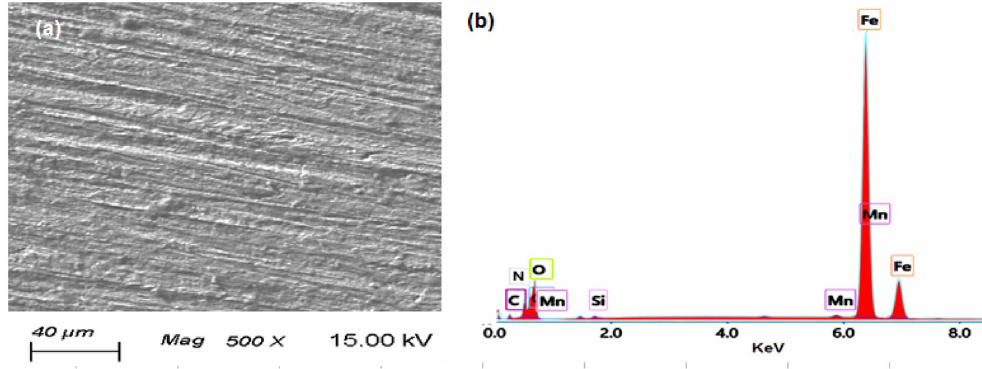
Figure 9. ( a ) SEM image and ( b ) EDX spectra for N80 C-steel pipe after immersion in the inhibited solution (15.0% HCl + 100 mg/l DMAEB).